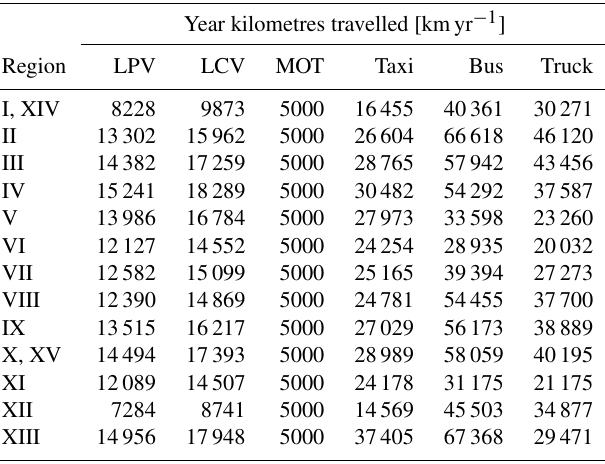
Table 3. Annual activity level per region and vehicle type (AL). Currently, there are 15 political regions in Chile numbered from I to XV, with XIII being the Santiago Metropolitan Region.